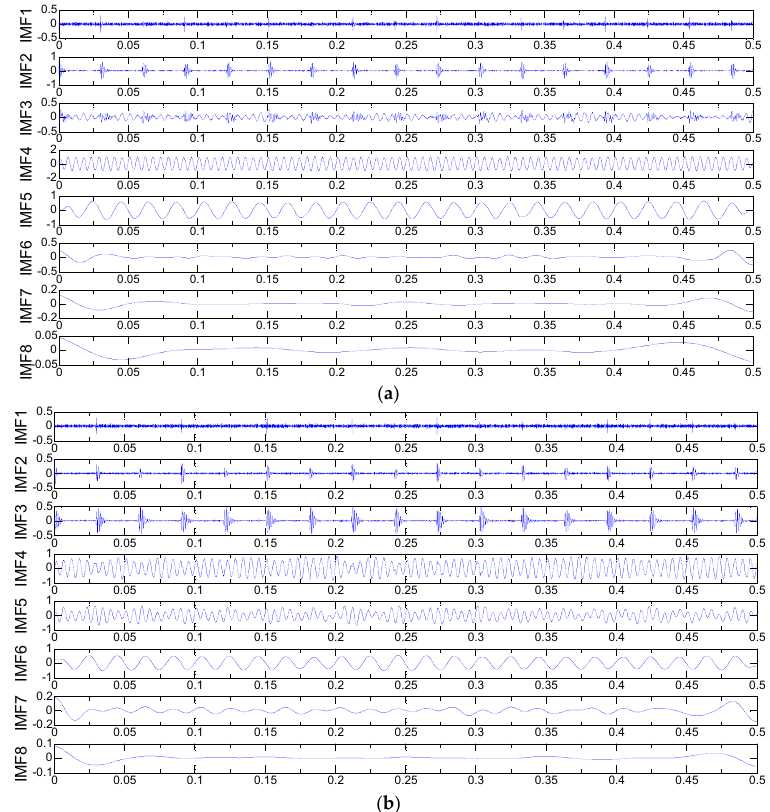
Figure 3. EEMD decomposition result with different sampling frequencies. ( a ) Decomposition result of EEMD with a sampling frequency of 9450 Hz; ( b ) decomposition result of EEMD with a sampling frequency of 14,100 Hz.